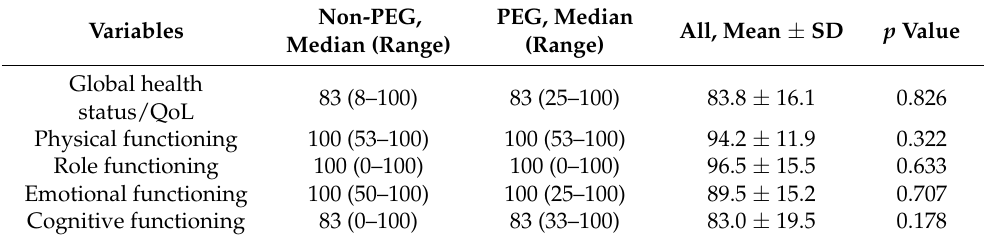
Table 3. Comparison of quality of life between non-PEG and PEG groups.